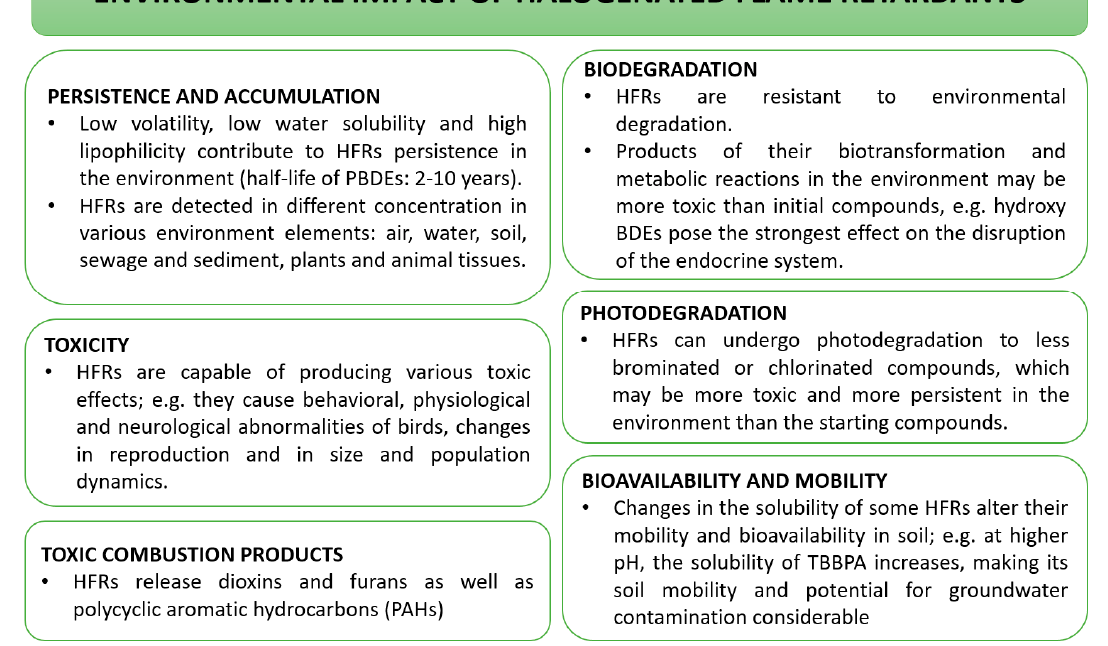
Figure 9. Environmental impact of halogenated flame retardants [135,138–140].